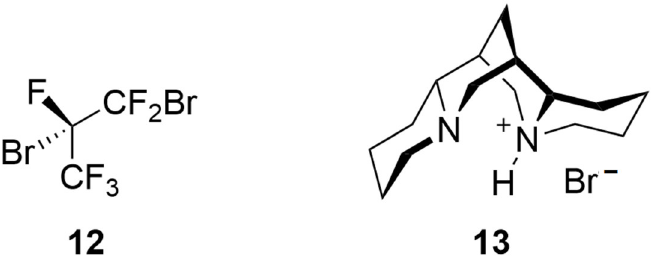
Figure 4. Structures of 1,2-dibromohexafluoropropane 12 and (–)-sparteine hydrobromide 13 .